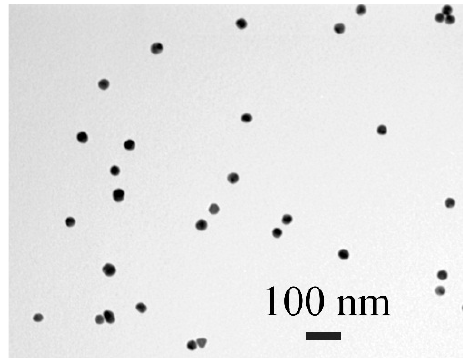
Figure 1. TEM photograph of AuNPs.